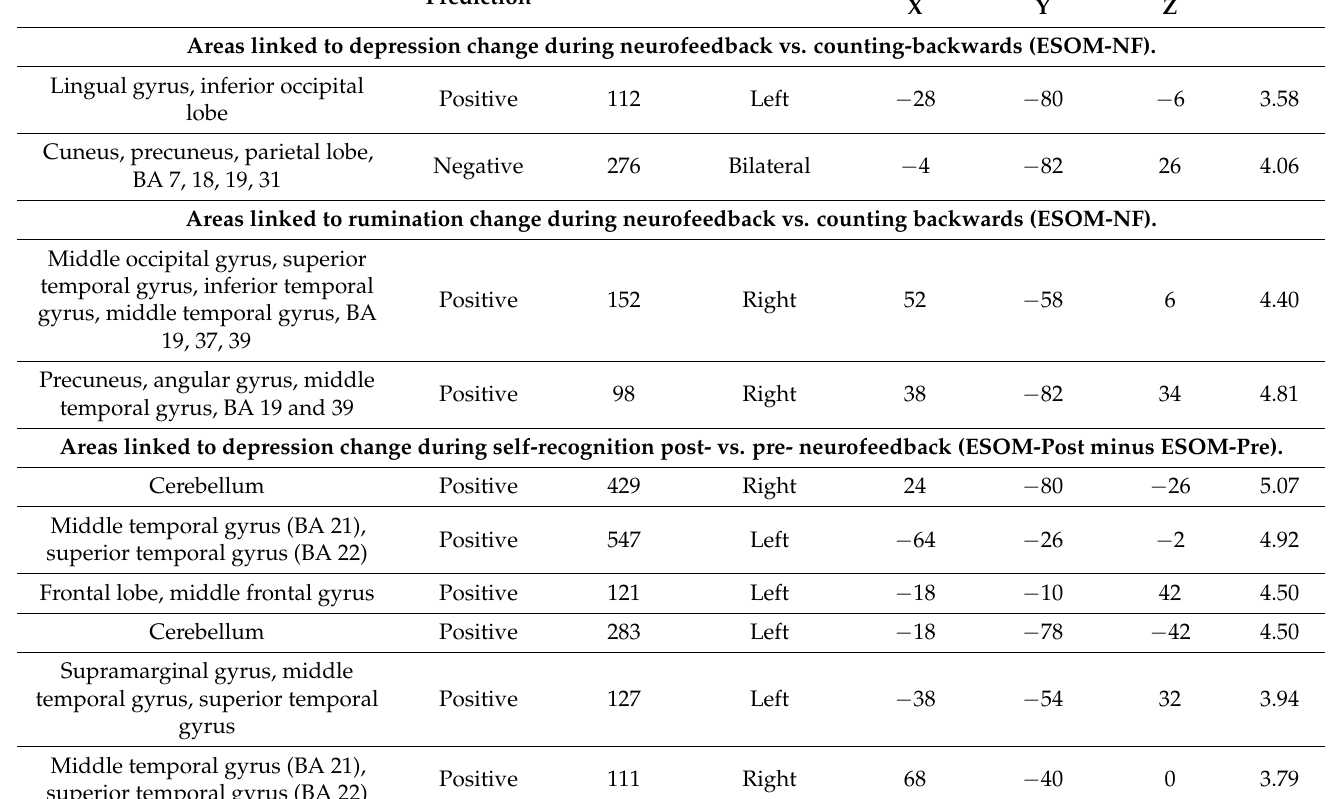
Table 2. Whole brain results in depressed youth only. Direction of Prediction